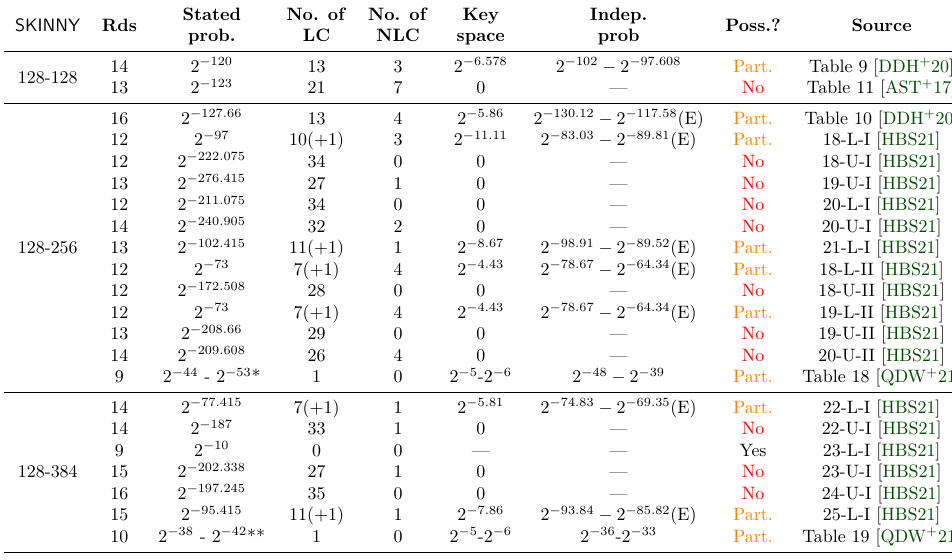
Table 2: The analysis of SKINNY-128 differential characteristics. “Stated prob.” refers